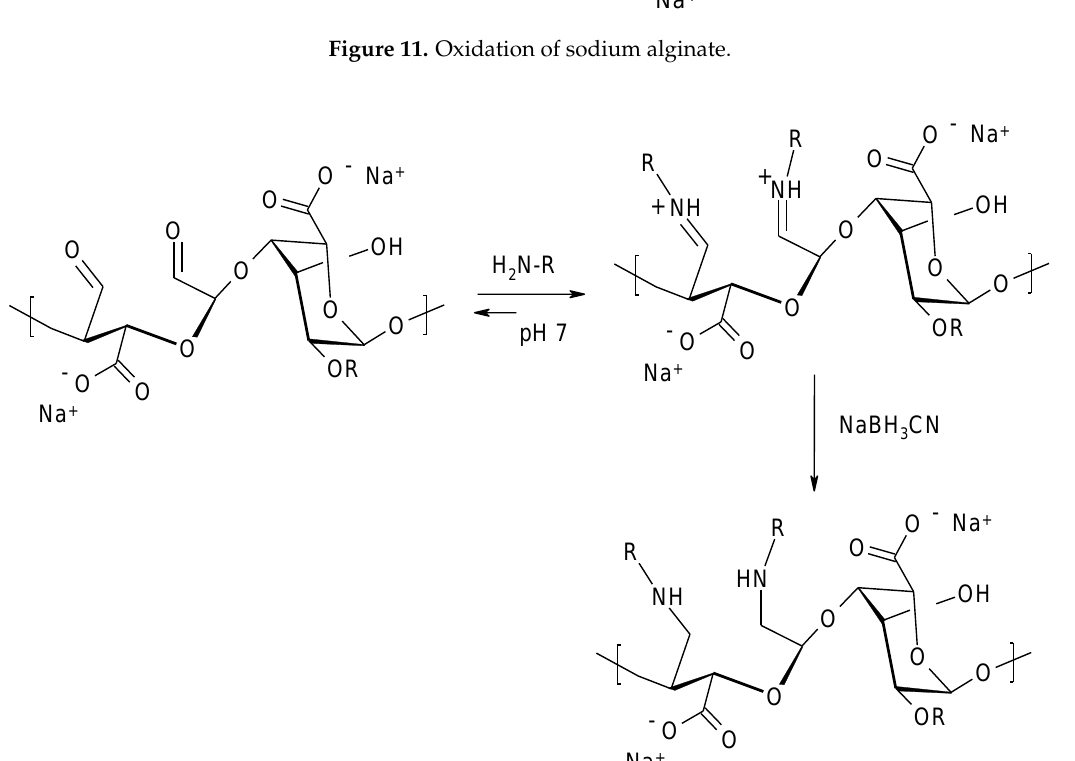
Figure 12. Reductive amination of oxidized sodium alginate.